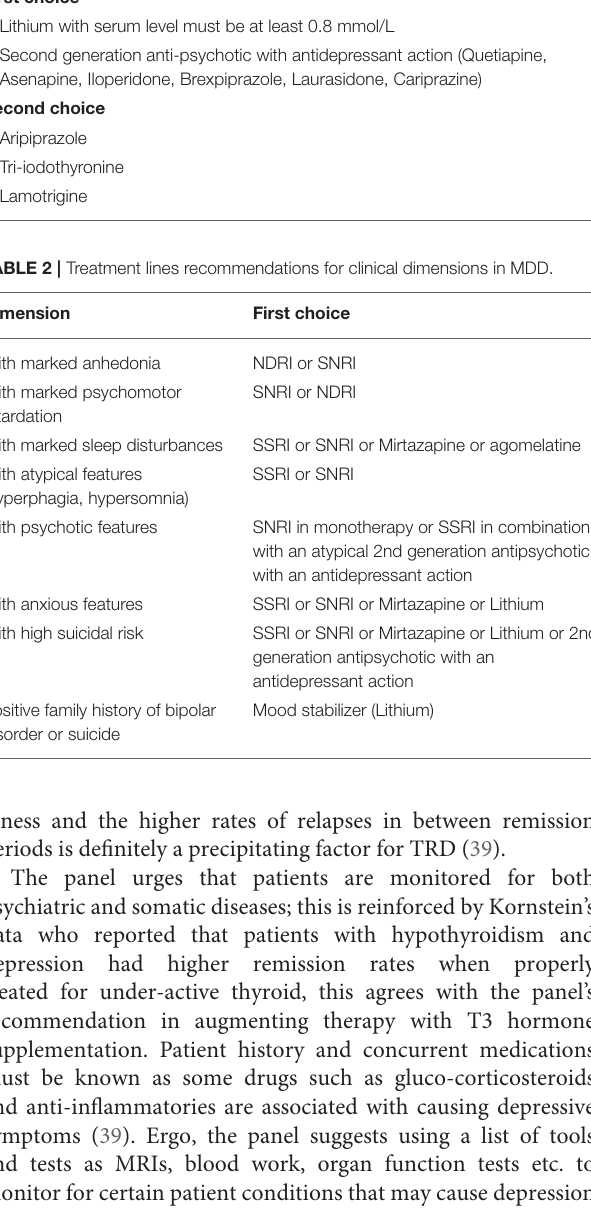
TABLE 1 | Therapeutic lines in augmentation strategy in non-psychotic patients. Potentiation treatment